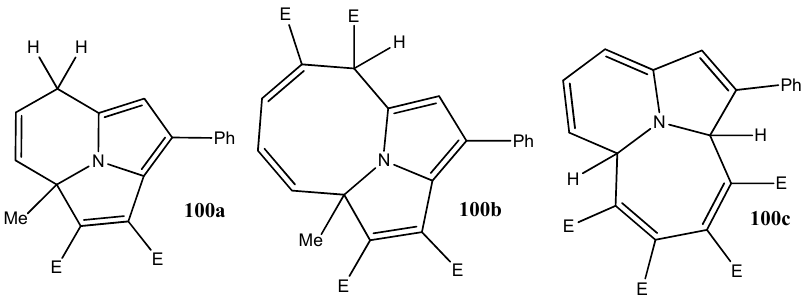
Scheme 55. 1:1 and 1:2 cycloadducts of 5-methylindolizine and DMAD.